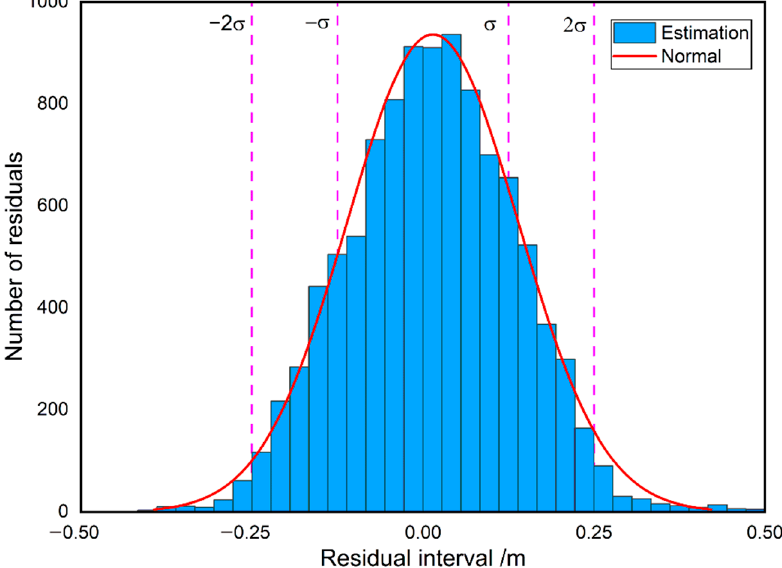
Figure 16. Statistics residual distribution histograms of SSHs estimated from the multi-GNSS PE combination method.